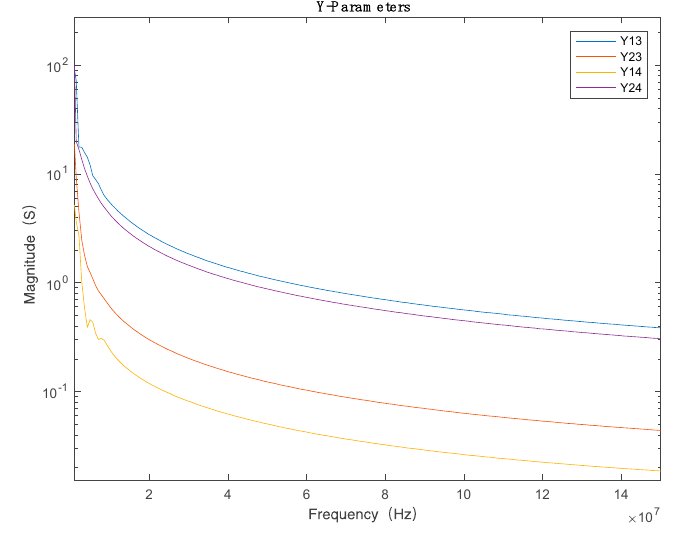
Figure 13. Y parameter simulation results.